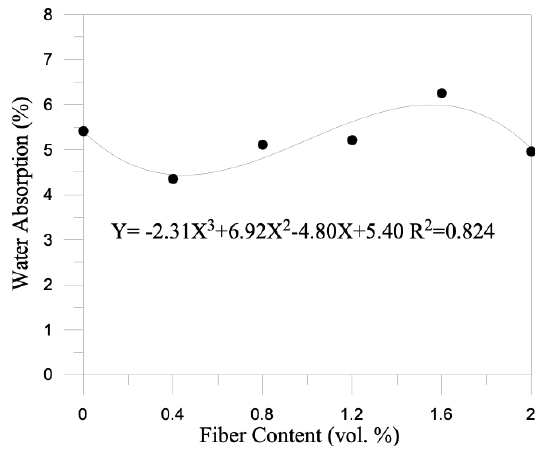
Figure 3. Absorption development curves of poly- olefin fiber concrete without slag.